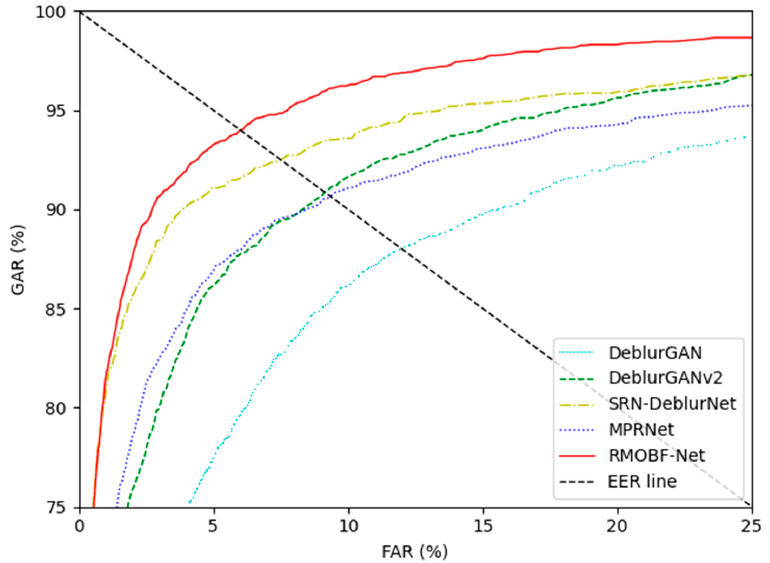
Figure 23. ROC curves of finger-vein recognition with SDU-DB for scheme 5 by various restoration methods (random motion blur and optical blur with intensity 19 × 19 (Gaussian filter size) and 19 (Gaussian filter standard deviation)).